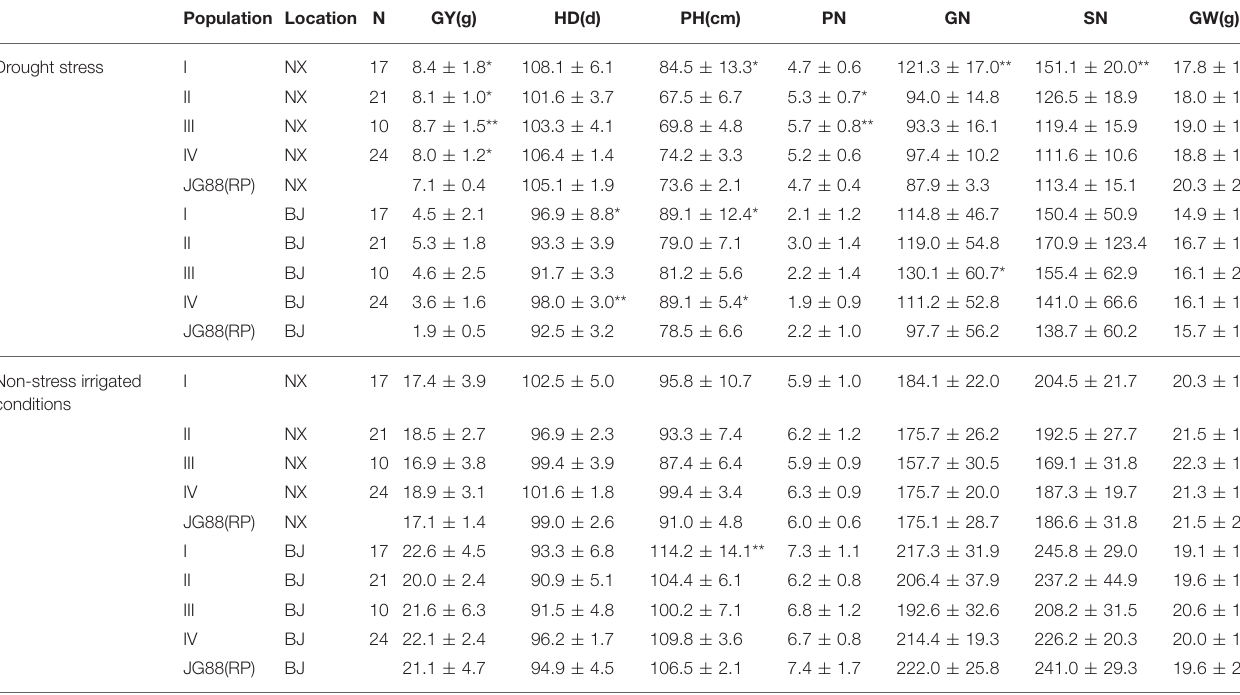
TABLE 2 | Mean performances of the DT introgression lines for grain yield and related traits selected from 4 backcross populations and their recurrent parent (JG88) in Ningxia (2013) and Beijing (2012) under the drought stress and non-stress irrigated conditions. Population Location N